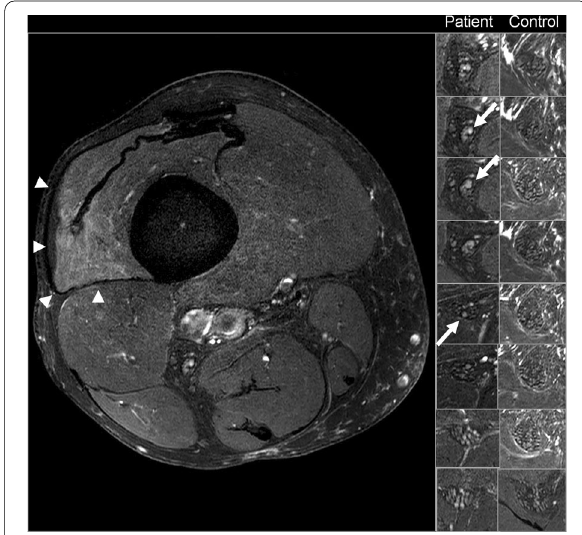
Fig. 1 MR neurography (high resolution T2 SPAIR) of the ischiadic nerve showing fascicular enlargement and T2 signal increase of nerve fibers consistent with inflammation (arrows). Denervation edema and a mild atrophy in M. vastus lateralis (arrow heads). Right: Comparison of MR neurography of the patient and MR neurography of an age‑matched, healthy